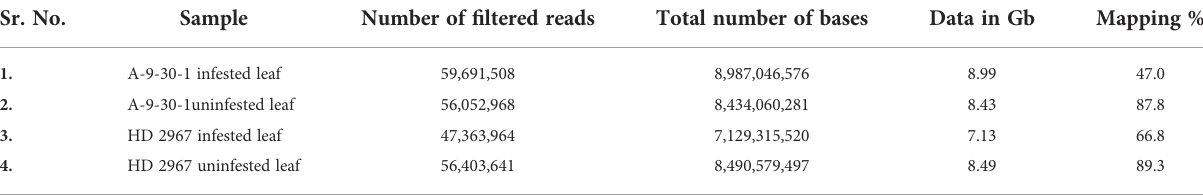
TABLE 1 High quality read statistics of susceptible genotype Triticum durum A-9-30-1 line and tolerant genotype Triticum aestivum HD 2967. Sr.